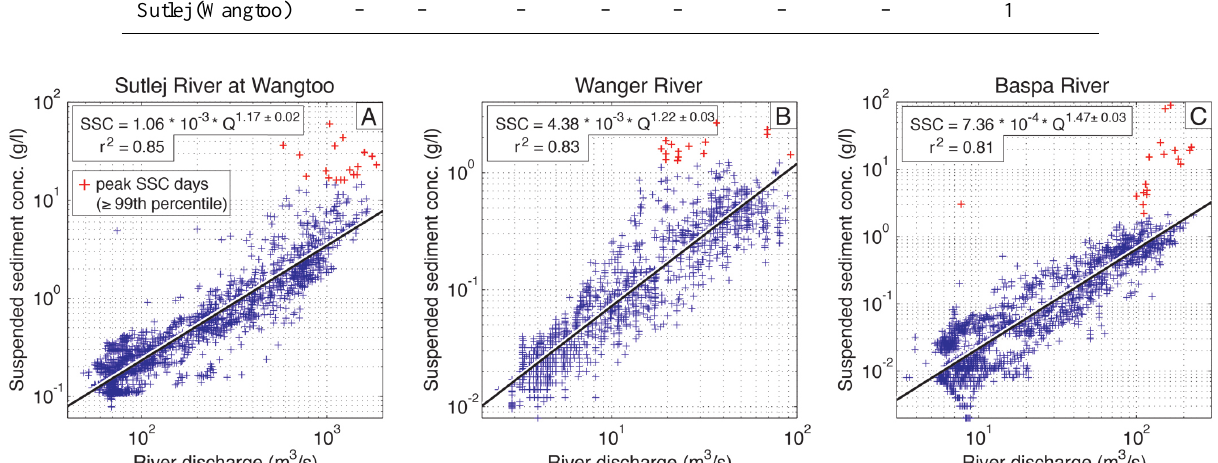
Fig. 3. Correlation of river discharge ( Q ) and suspended sediment concentration (SSC) for the Sutlej River at Wangtoo (A) , the Wanger River (B) , and the Baspa River (C) . These correlations are subject to seasonal variations due to hysteresis effects and high sediment-transport events and therefore not suited for sediment flux predictions. Note the different scales of the